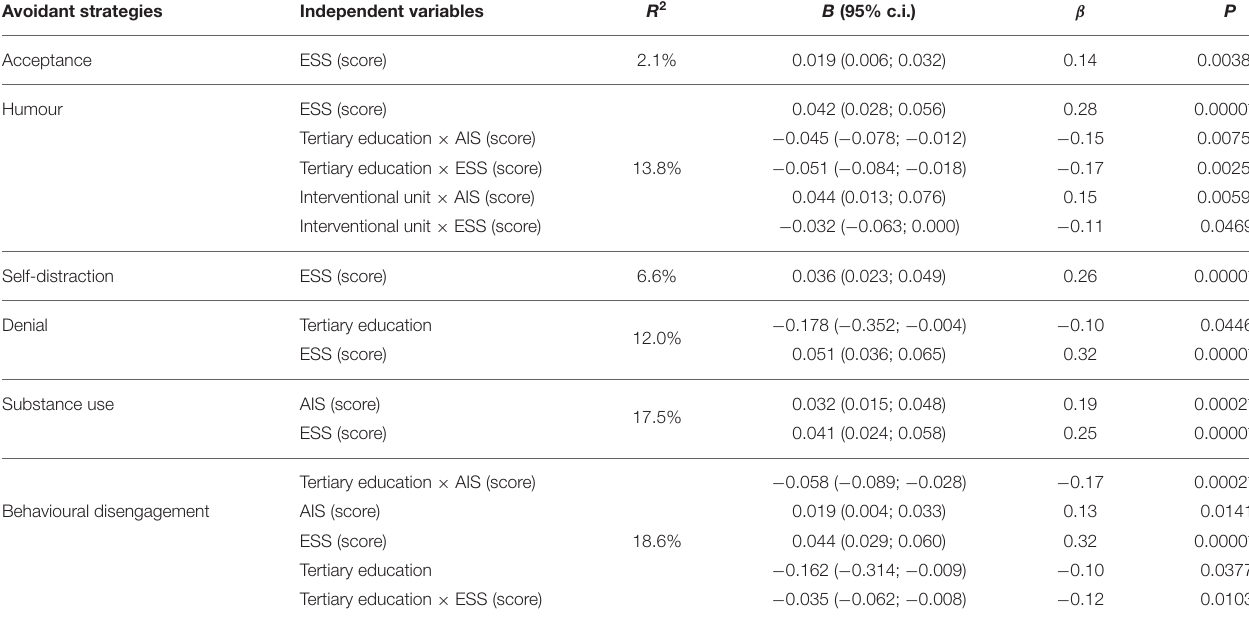
TABLE 5 | Regression models for avoidant strategies ( N = 448). Avoidant